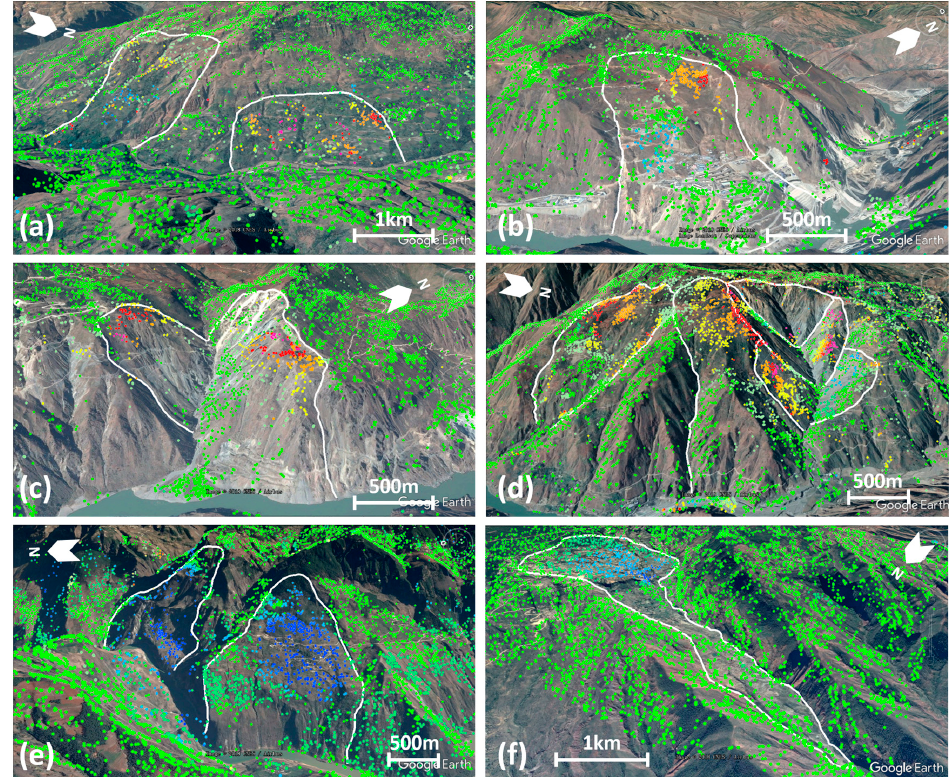
Figure 5. Enlarged deformation rate maps of detected landslides superimposed on Google earth images; the color bar is same as in Figure 4. Graphs ( a – f ) correspond to the area A to F marked in Figure 4a. The white curve in each graph is the approximate boundaries of the suspected landslides.